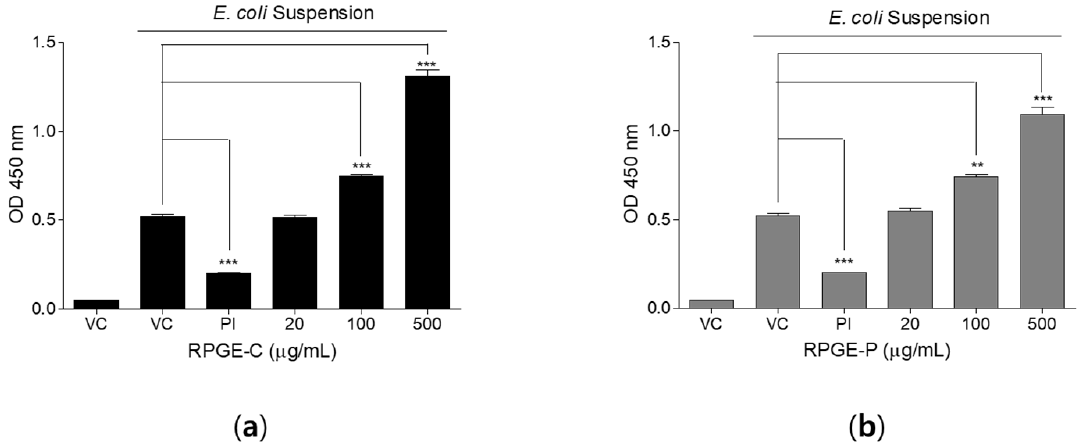
Figure 2. Effect of RPGE on the phagocytic activity of RAW 264.7 cells. ( a ) RPGE-C; ( b ) RPGE-P. PI, phagocytosis inhibitor. Values are represented as the mean ± SEM. ** p < 0.01 and *** p < 0.001 when compared with the VC treated with an E. coli suspension.